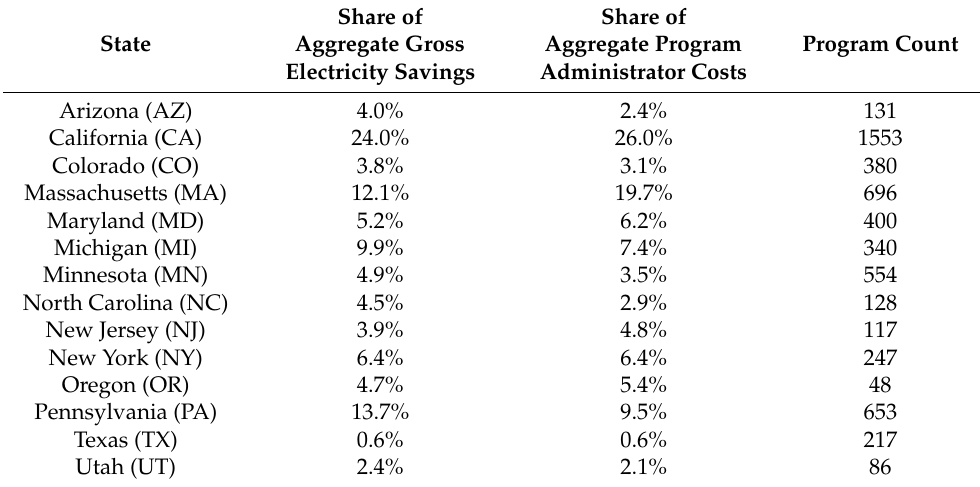
Table 2. Share of aggregate gross electricity savings and program administrator spending by state.